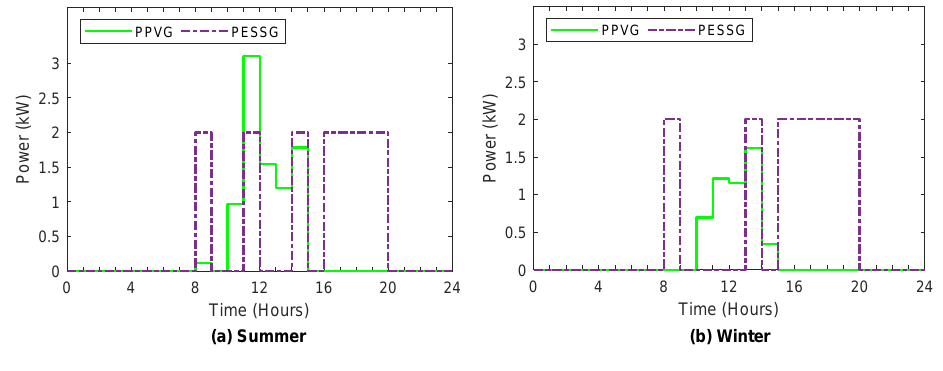
Figure 10. Sold power to the